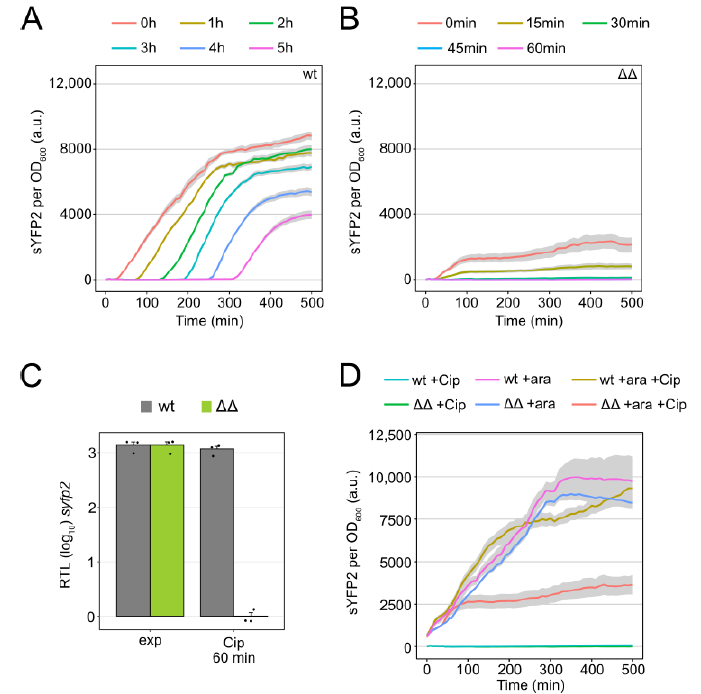
Figure 3. Gene expression is inhibited in mutant ∆ 1-41 ∆ istR upon ciprofloxacin. ( A , B ) sYFP2 fluorescence from plasmid pBAD- syfp2 was monitored in a microplate reader. Strains wt pBAD- syfp2 ( A ) and ∆∆ pBAD- syfp2 ( B ) were treated with Cip (0.1 µ g mL − 1 ; 10 × MIC) during the exponential phase (OD 600 of ~0.4), which corresponds to time point 0 min. sYFP2 expression was induced by adding 0.2% L-Ara at the indicated time points during Cip treatment. Fluorescence measurements were normalized to the corresponding OD 600 measurements. Data represent the mean (colored lines) and SEM (grey ribbons; n = 3). ( C ) Relative transcript levels (RTL, log 10 ) were calculated by qRT-PCR to assess syfp2 induction upon treatment with L-ara. RNA samples were collected before and 30 min after induction with 0.2% L-ara, either during the exponential phase (exp, OD 600 of ~0.4) or after 60 min of Cip treatment (0.1 µ g mL − 1 ; 10 × MIC). Bars represent the mean ( ± SEM; n = 3). Black dots indicate the results of individual biological experiments. ( D ) sYFP2 fluorescence from plasmid pBAD- syfp2 was monitored in a microplate reader. sYFP2 expression was induced by 0.2% L-Ara (+ara) 30 min before treatment with Cip (0.1 µ g mL − 1 ; 10 × MIC). Treatments with L-ara or Cip alone served as controls. Fluorescence measurements were normalized to the corresponding OD 600 measurements. Data represent the mean (colored lines) and SEM (grey ribbons; n = 3). (wt: wild type MG1655; ∆∆ : ∆ 1-41 ∆ istR